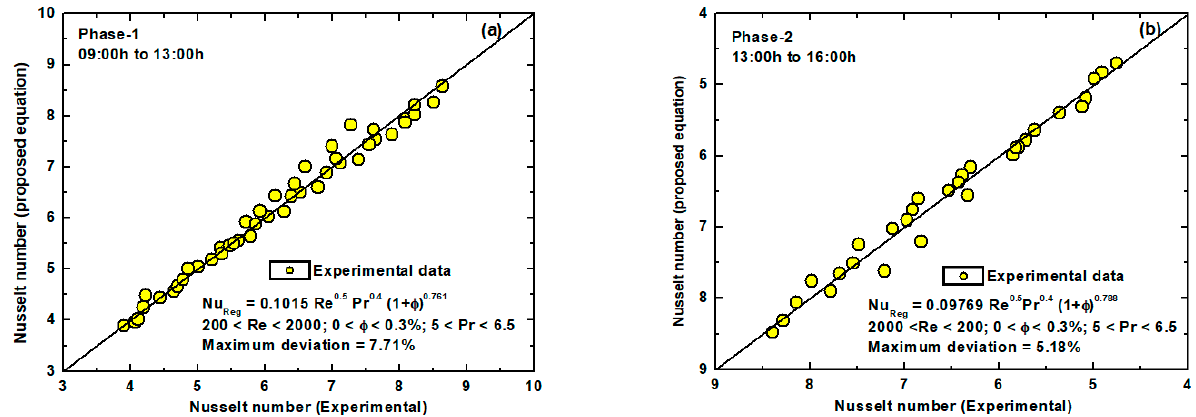
Figure 13. Experimental Nusselt number against proposed equation; Phase-1 ( a ), and Phase-2 ( b ).